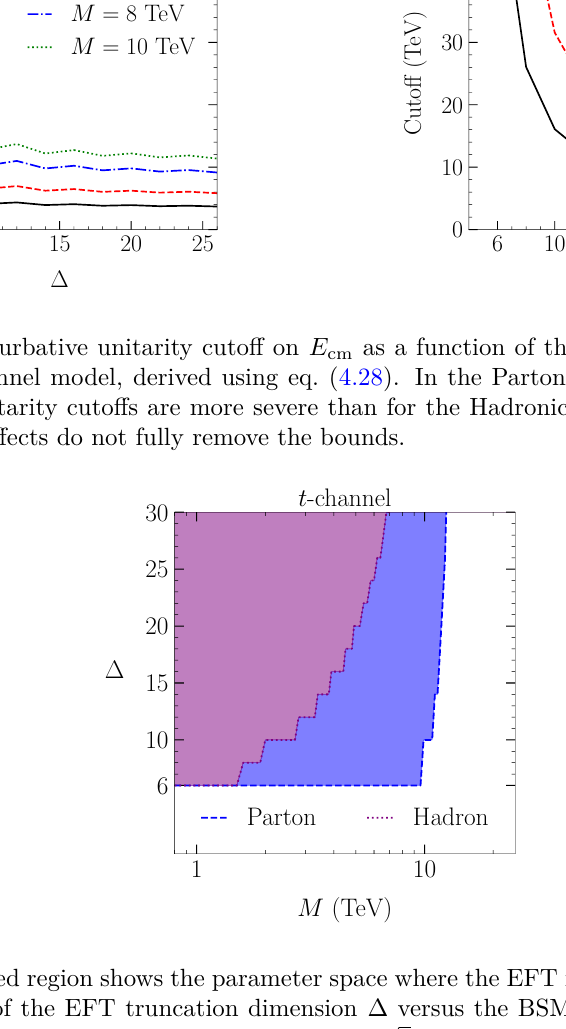
√ √ s ) = 14 TeV. The inclusion of PDF ˆ s (